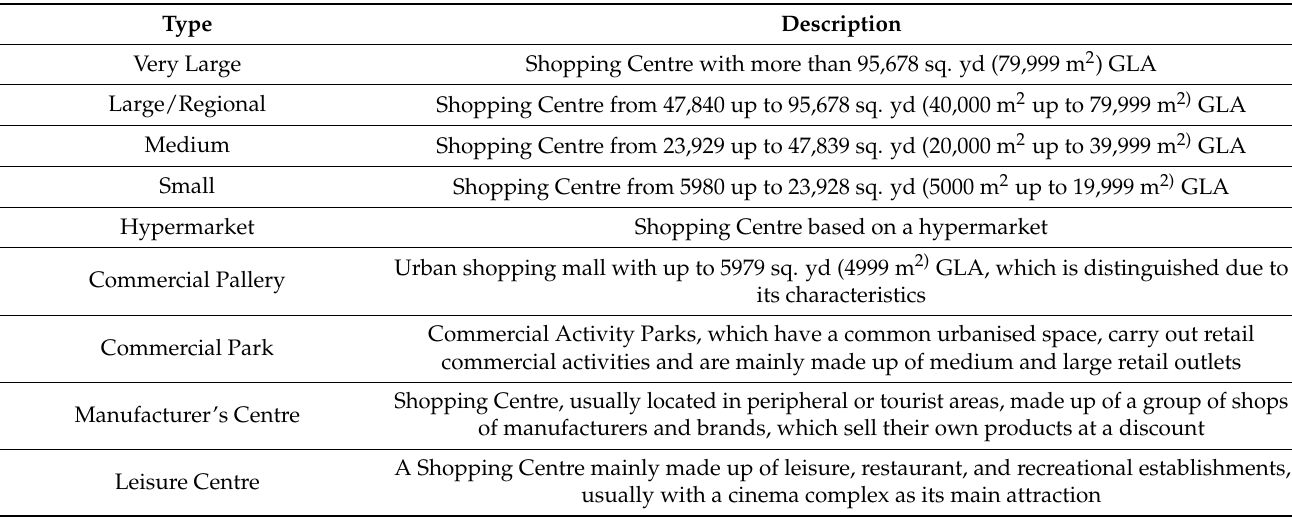
Table 1. Classification of shopping centres 1